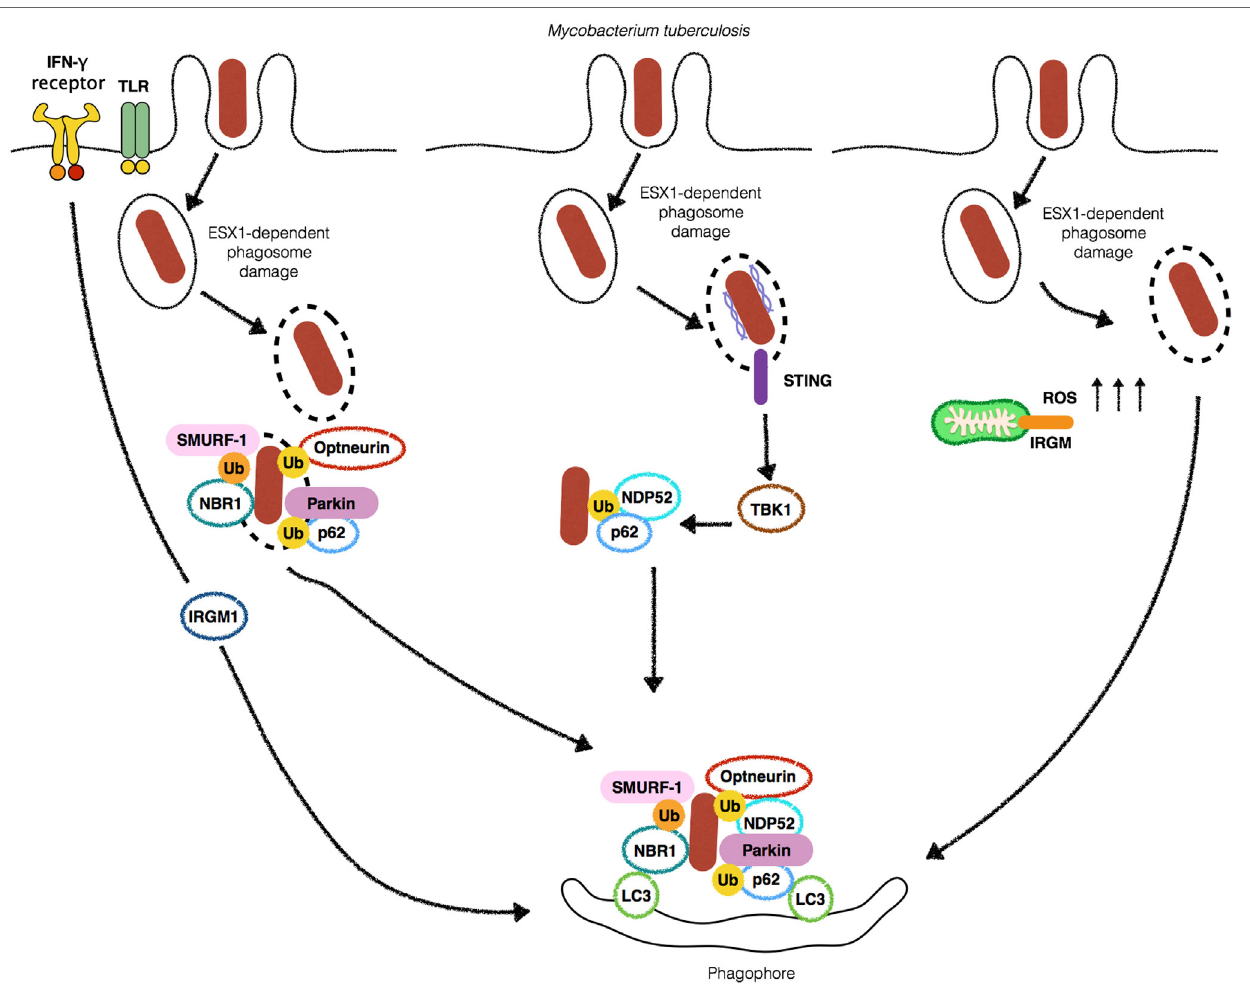
FigURe 1 | Autophagy targets Mycobacterium tuberculosis (Mtb) by different mechanisms. Stimulation with IFN- γ or Toll-like receptors (TLRs) ligands leads to an increase in the localization of (Mtb) into autophagosomes (left). 6-kDa early secretory antigenic target (ESAT-6) secretion system 1 (ESX-1)-induced phagosomal damage induces the exposure of Mtb to cytosolic autophagy adaptors such as Optneurin, p62, NDP52 and NBR1 which bind to ubiquitin associated with Mtb as a consequence of the E3-ligases SMURF-1 and Parkin, culminating with targeting of the bacteria for autophagic degradation (center). Extracellular bacterial DNA from Mtb is detected by STING to activate TBK1 and lead to Mtb ubiquitination and recruitment of p62 and NDP52 (middle-left). IRGM-induced increase in ROS provokes autophagic targeting of Mtb (right).